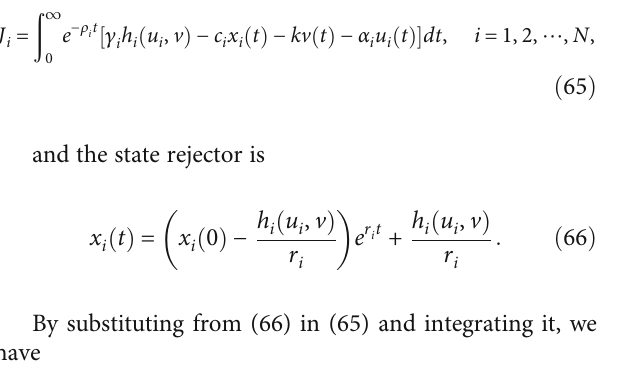
Figure 4: The relation between the harvest function h ð u weight parameters w i .